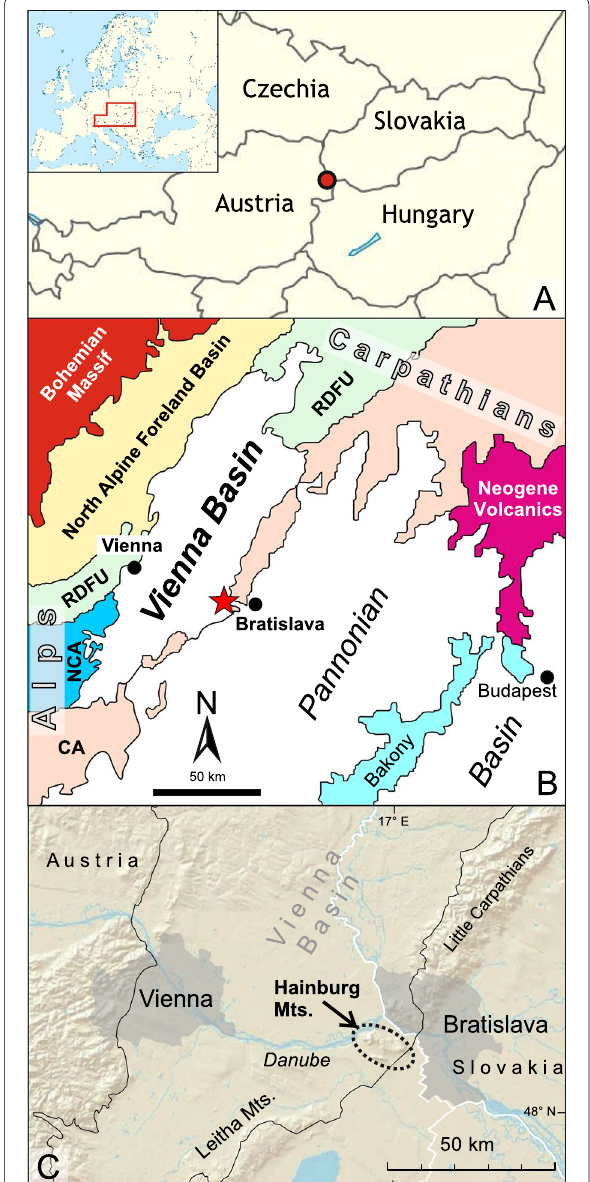
Fig. 2 A General location maps showing the study area. B Simplified geological map with the position of the Vienna Basin related to the Alpine-Carpathian Mountains and the Pannonian Basin (modified after Wessely, 1998). C Topographic map (DEM) of the Central Vienna Basin (between Vienna and Bratislava) with the Hainburg Mountains indicated as well as the Little Carpathians and the Leitha Mountains; RDFU Rhenodanubian Flysch Unit, NCA Northern Calcareous Alps, CA Central